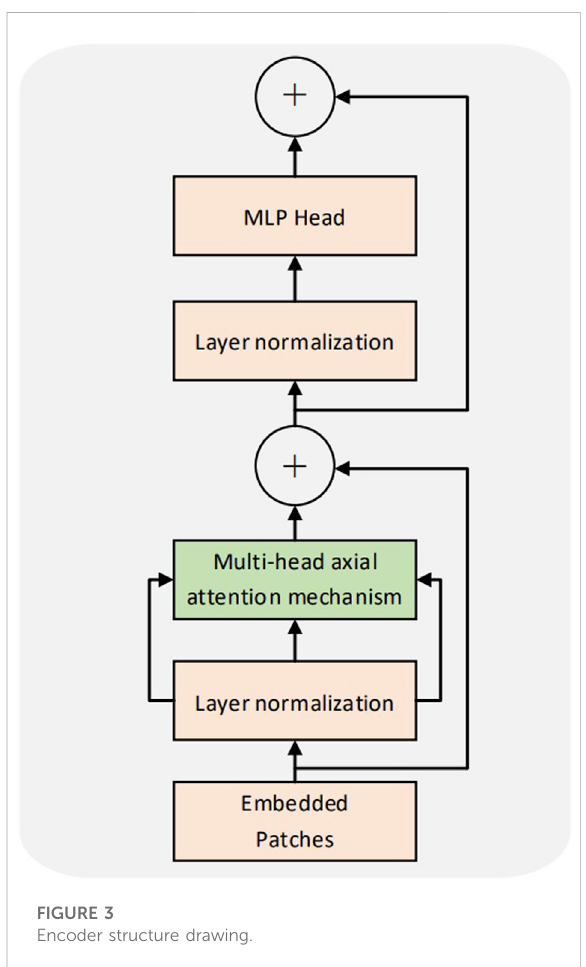
FIGURE 3 Encoder structure